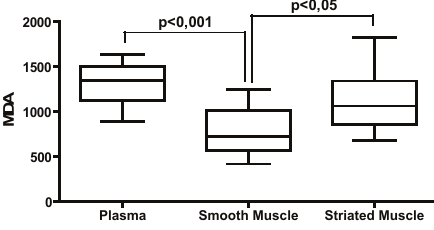
FIGURE 5 - Intragroup comparison of the levels of MDA (ng/mL) in the various analysed tissues for the exercise group (ANOVA;